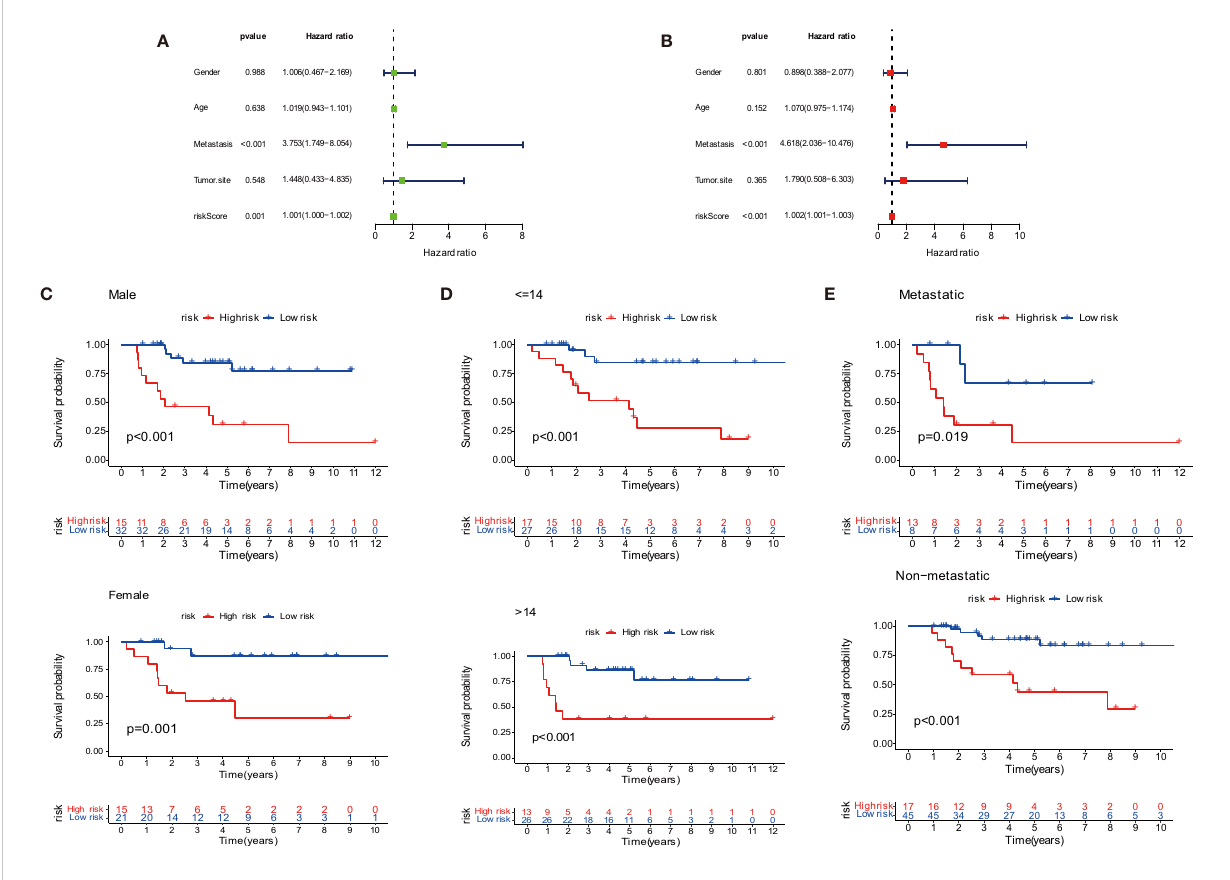
FIGURE 4 Prognosis of the anoikis-related lncRNA signature in osteosarcoma patients. (A) Univariate COX regression analysis. (B) Multivariate COX regression analysis. (C) Survival curve of gender. (D) Survival curve of age. (E) Survival curve of